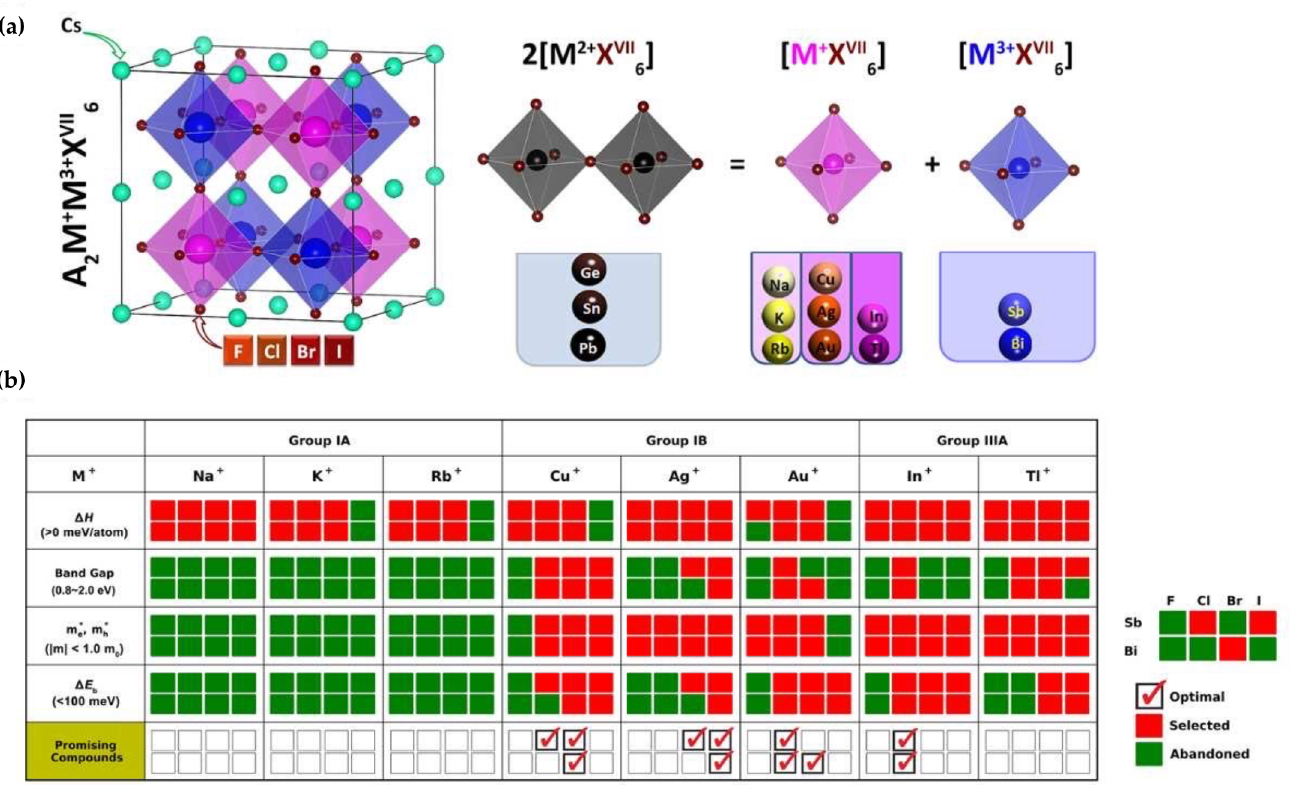
Figure 1. ( a ) Suggested structure of double halide perovskite with a formula of A 2 B + B 3+ X 6 using the idea of transmutation and; ( b ) materials screening process considering the decomposition enthalpy ( ∆ H), bandgap (E g ), carrier effective masses (m e * and m h *) and exciton binding energy ( ∆ E). Reproduced with permission from [54]. Copyright 2017, American Chemical Society.